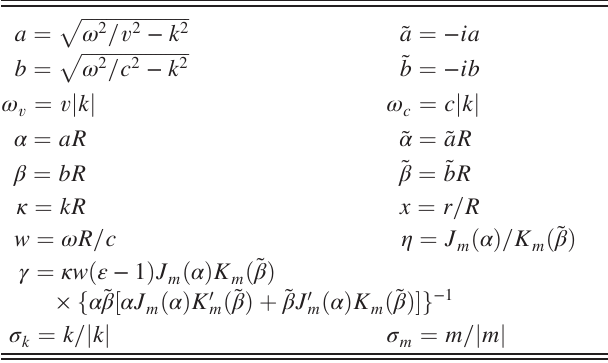
ffiffiffi p ε in the